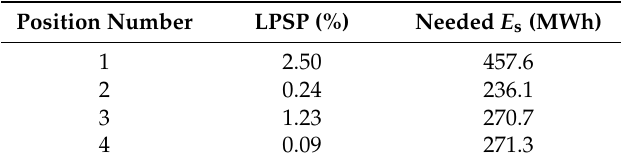
Table 7. Loss of power supply probability (LPSP) results using a probabilistic approach (2 days continuing the power deficit).